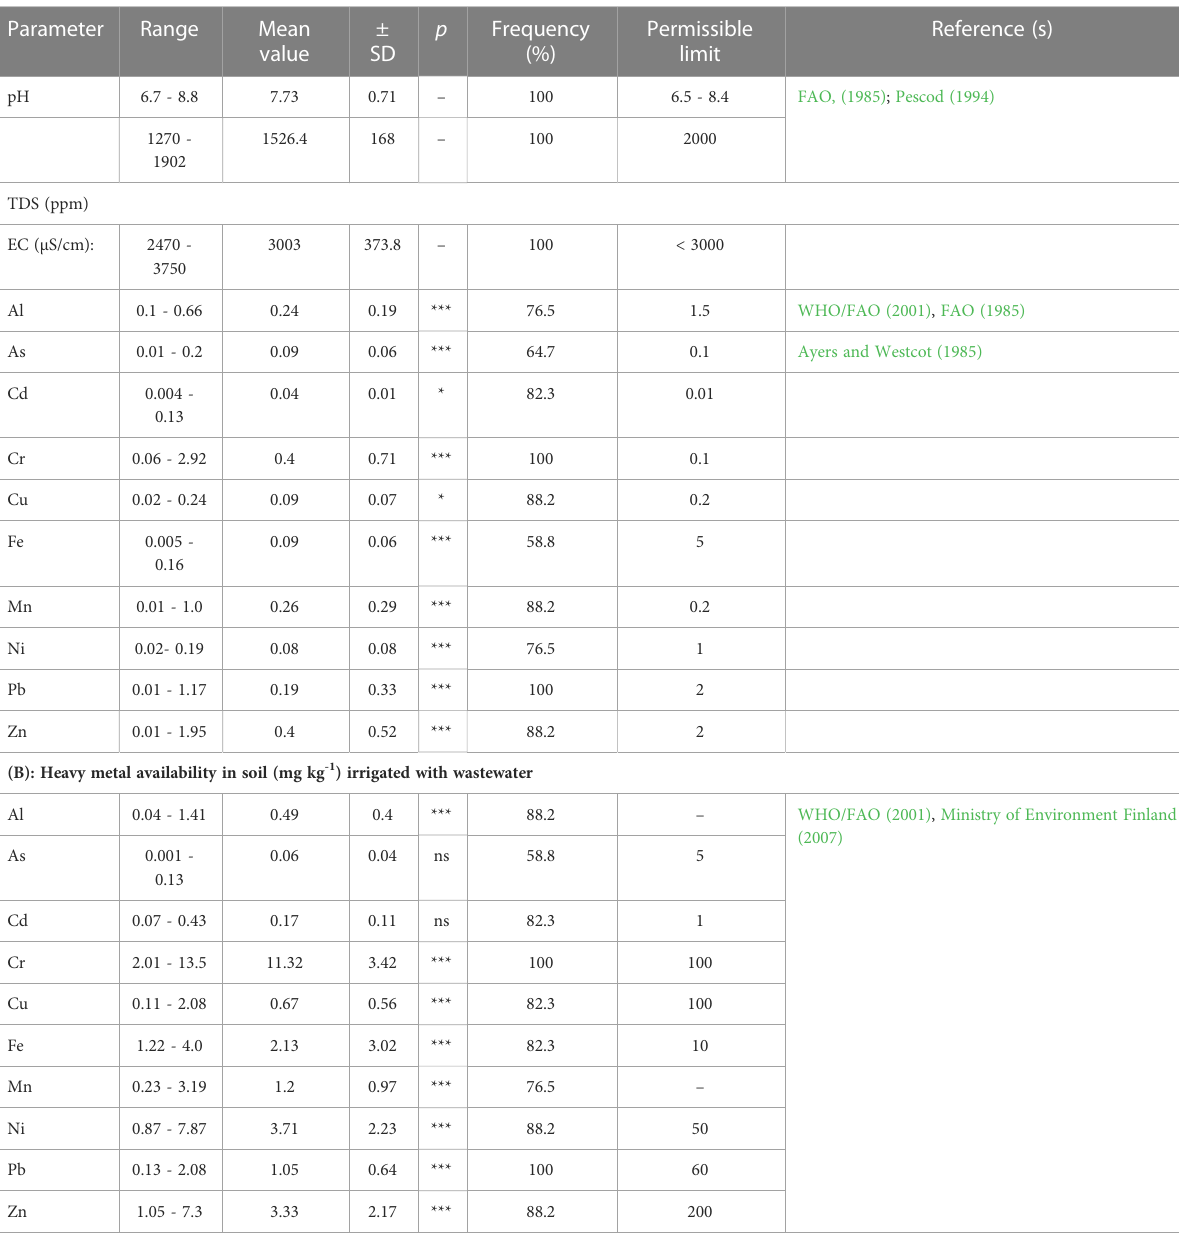
TABLE 1 (A) Characteristics of wastewater and heavy metal availability (mg L -1 ) in wastewater used for irrigation purpose.